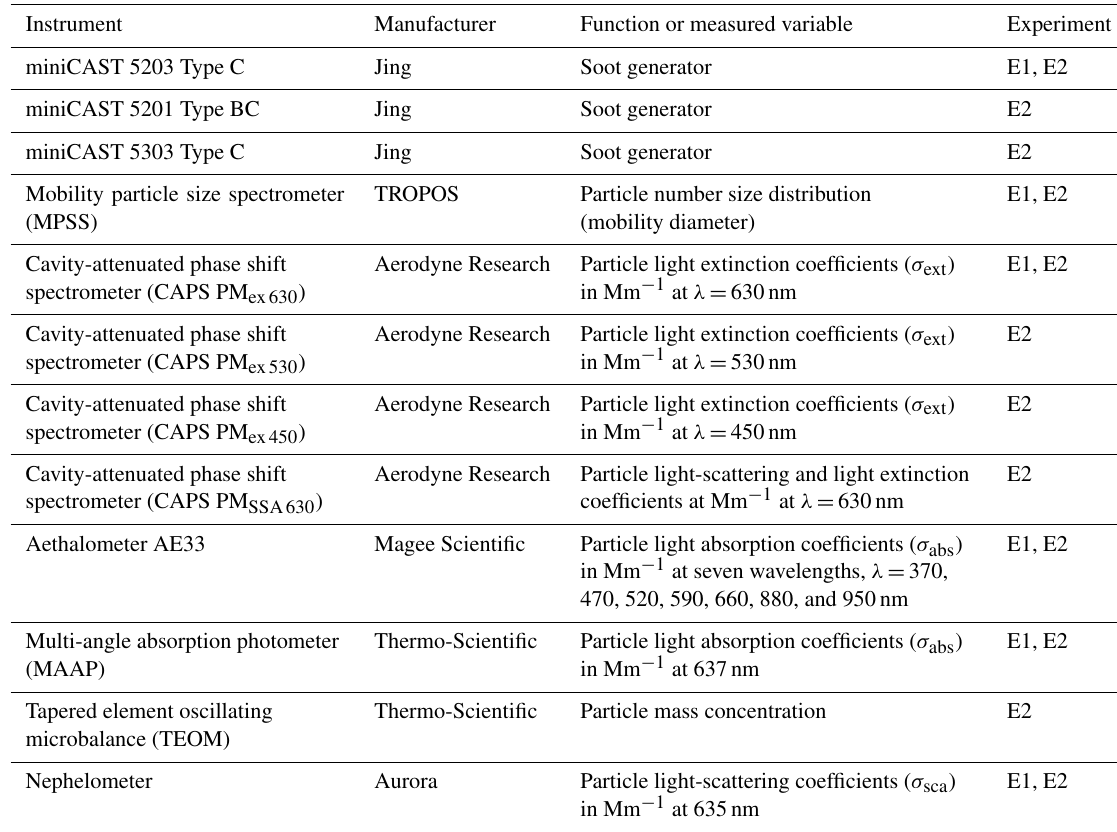
Table A1. Details of the instruments used in E1 and E2. Instrument Manufacturer Function or measured variable